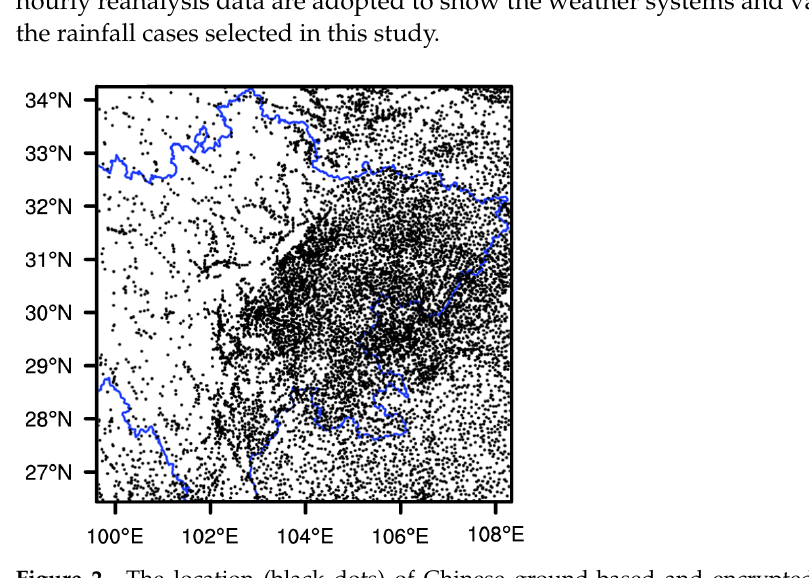
Figure 2. The location (black dots) of Chinese ground-based and encrypted stations over the Sichuan